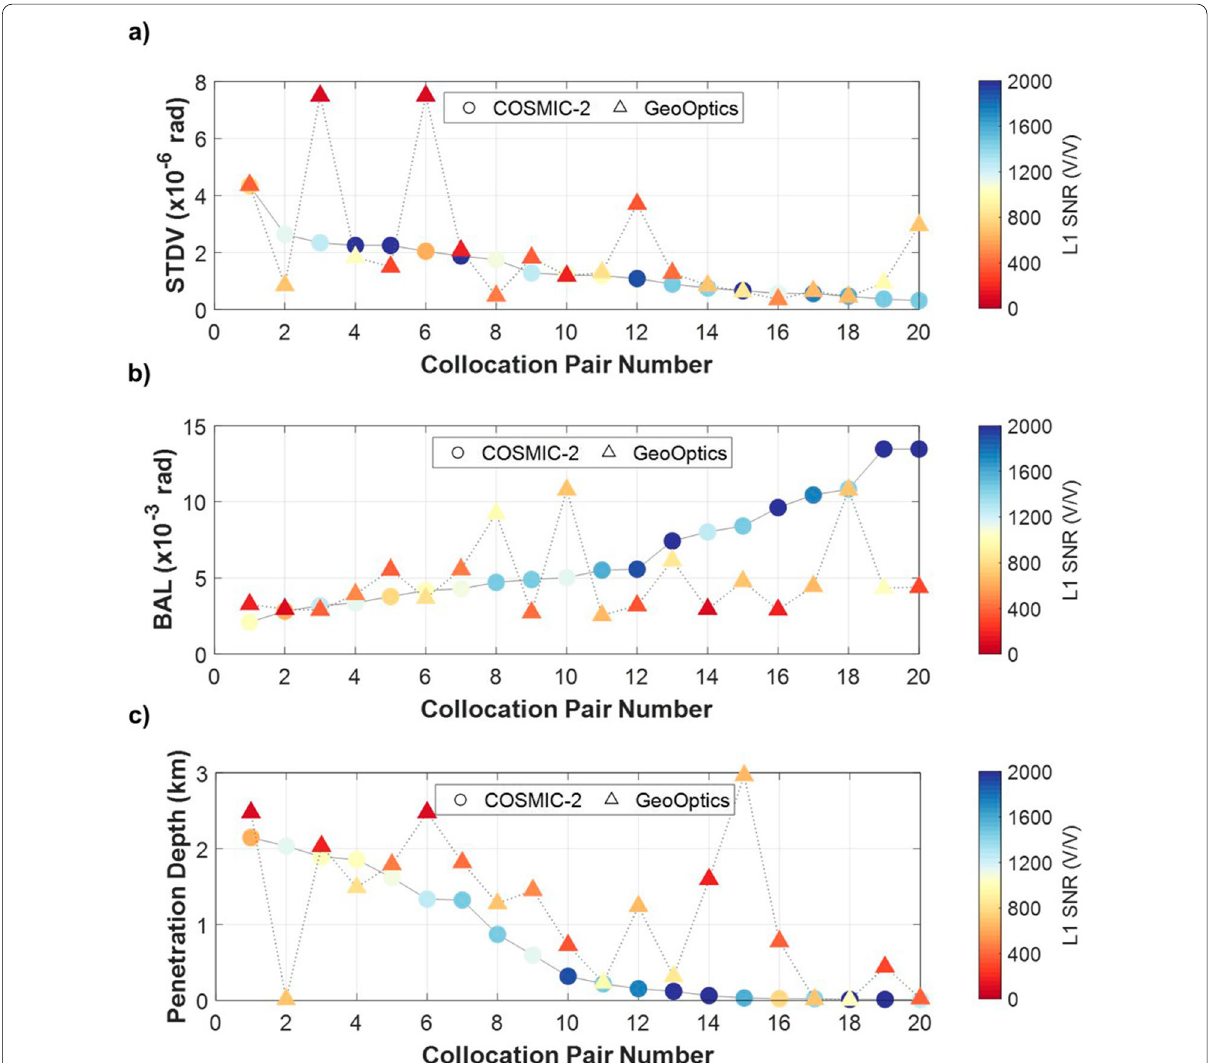
Fig. 9 a STDV (sorted by COSMIC-2 STDV), b BAL (sorted by COSMIC-2 BAL), c penetration depth (sorted by COSMIC-2 penetration depth) for each collocation